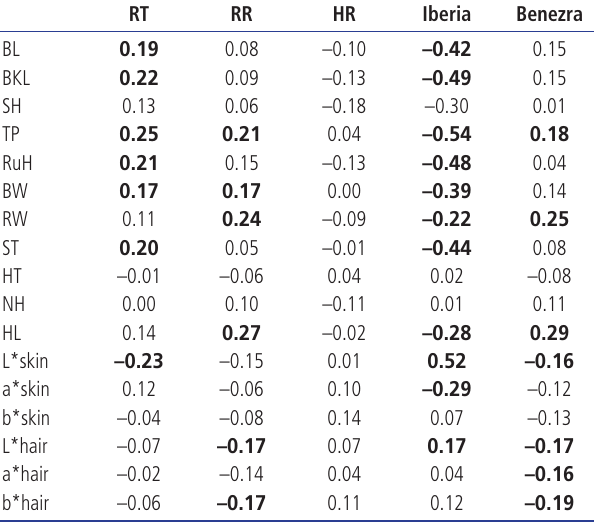
Table 5. Breed and sex interaction on physical characteristics during three days of